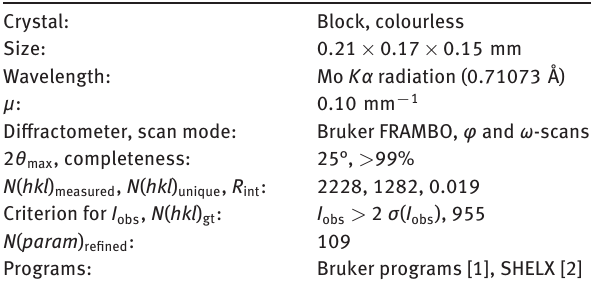
Table 1: Data collection and handling.